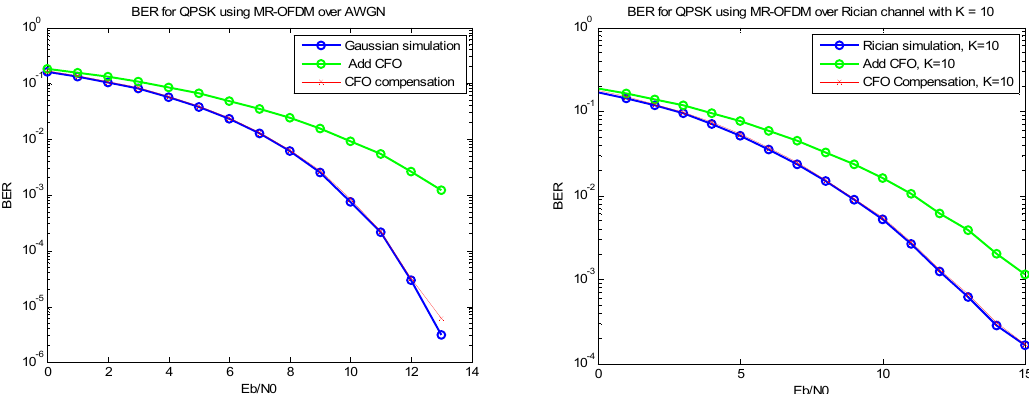
Figure 9. Simulation BER per Eb / N0 of MR-OFDM over the Gaussian and Rician channels with a constant velocity (v = 75 m/s) .